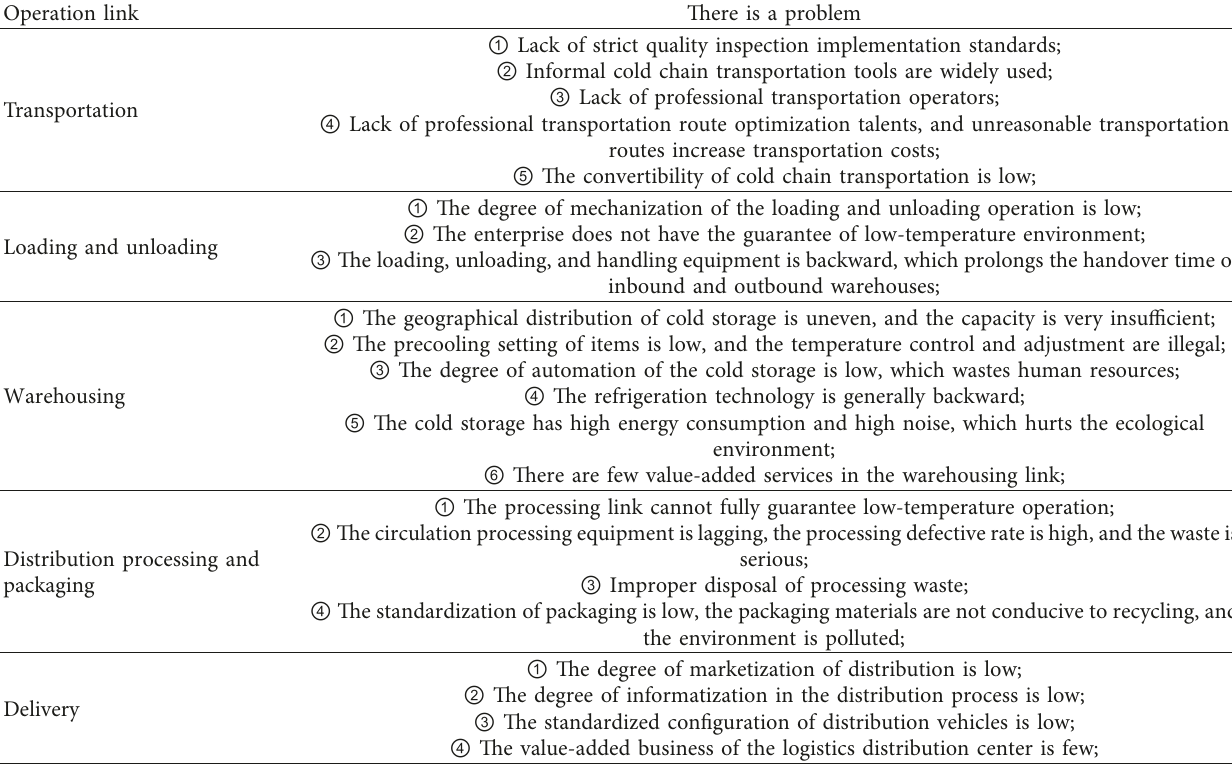
Table 3: Problems existing in cold chain logistics construction of fresh products.